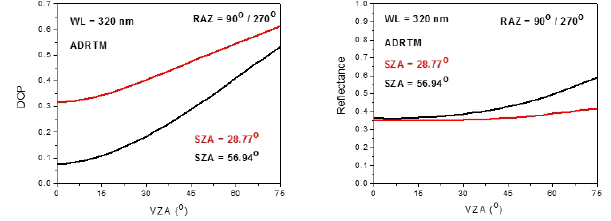
Figure 21. Same as in Fig. 20 but at RAZs of 90 and 270 ◦ .